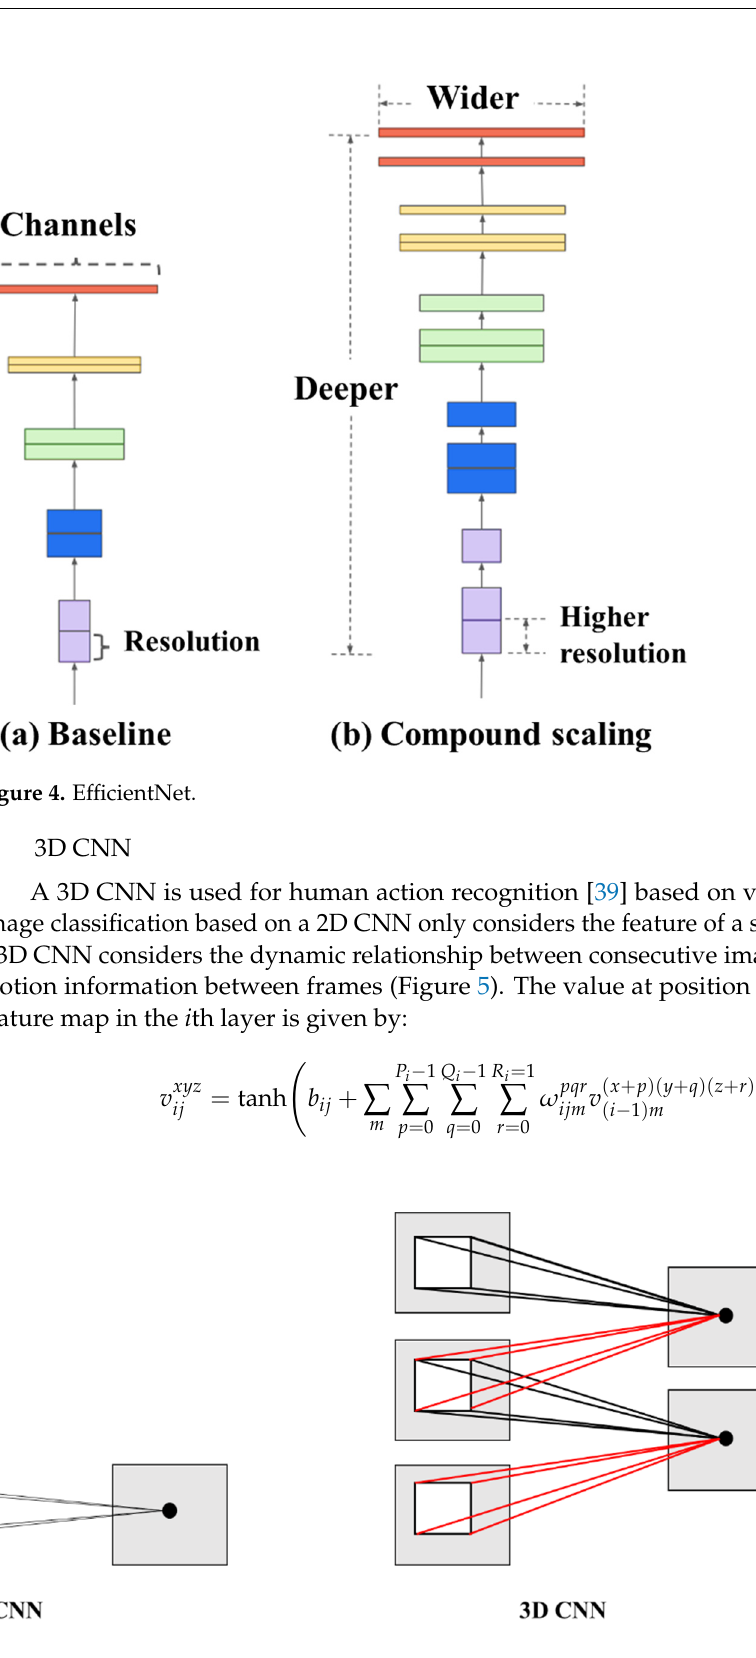
Figure 5. Standard 2D and 3D